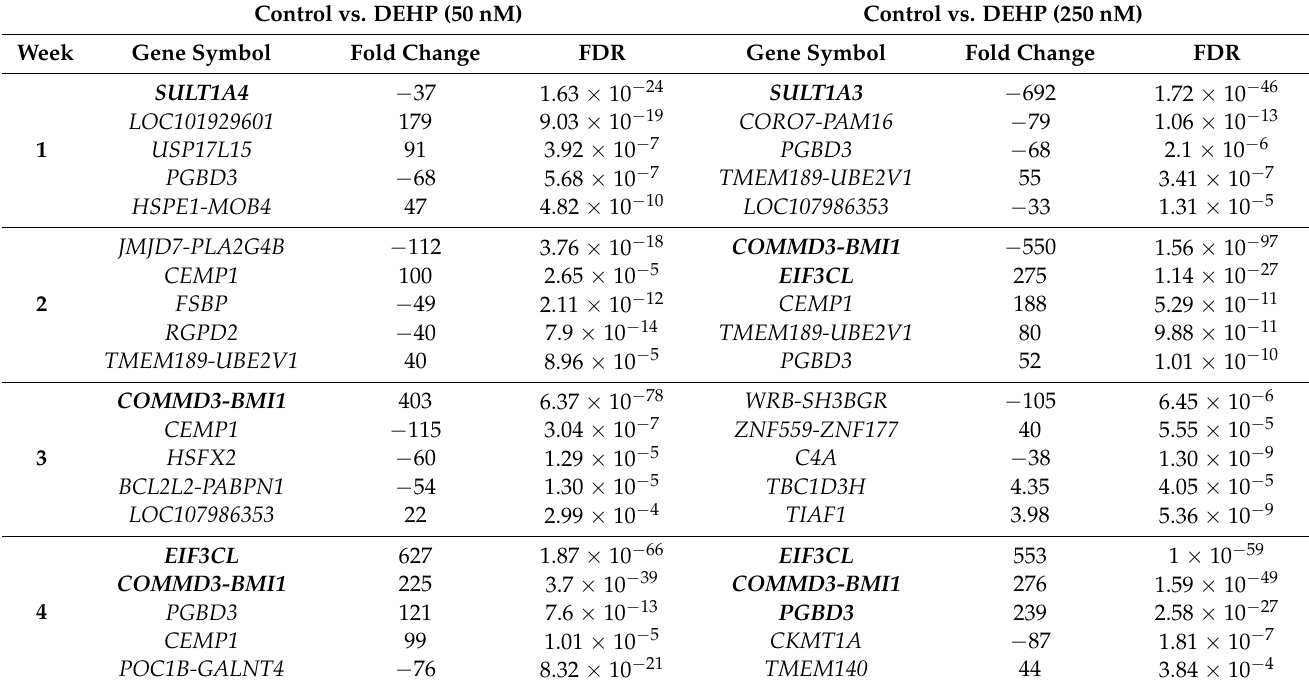
Table 2. The top five DEGs after 1, 2, 3, and 4 weeks of the repeated DEHP50 and DEHP250 exposure under the basal conditions.